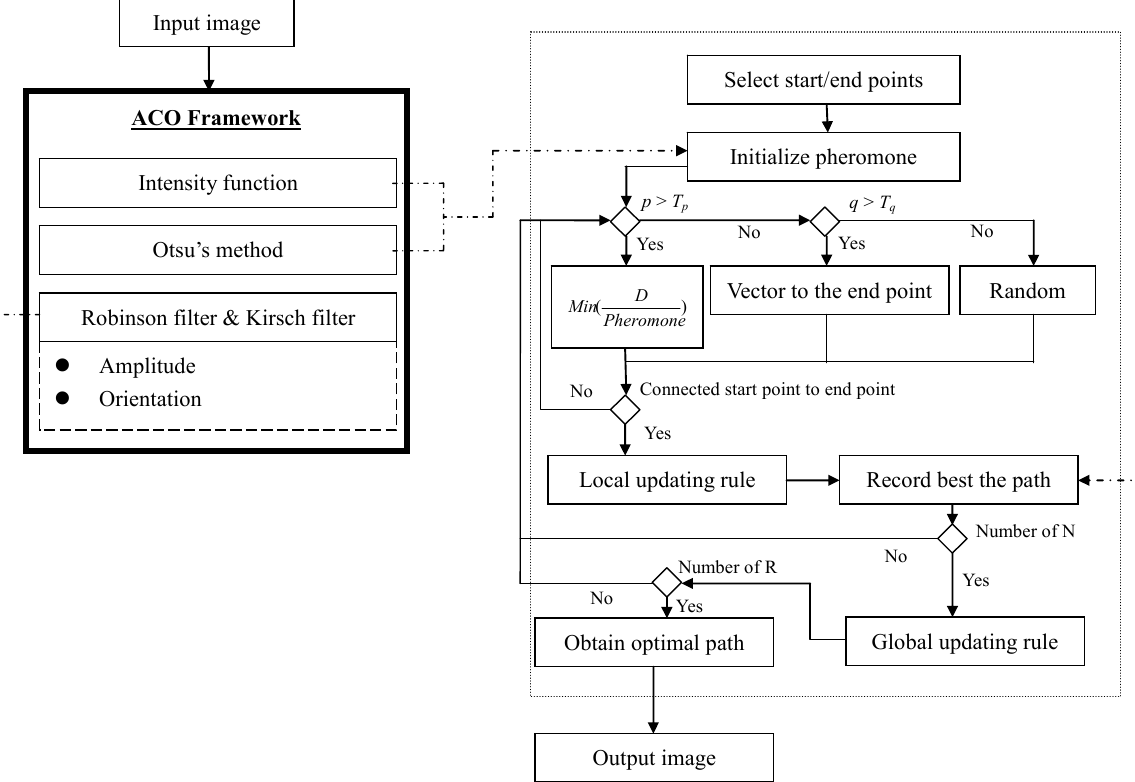
Figure 10. The details of proposed ACO framework for lung fissure tracking.